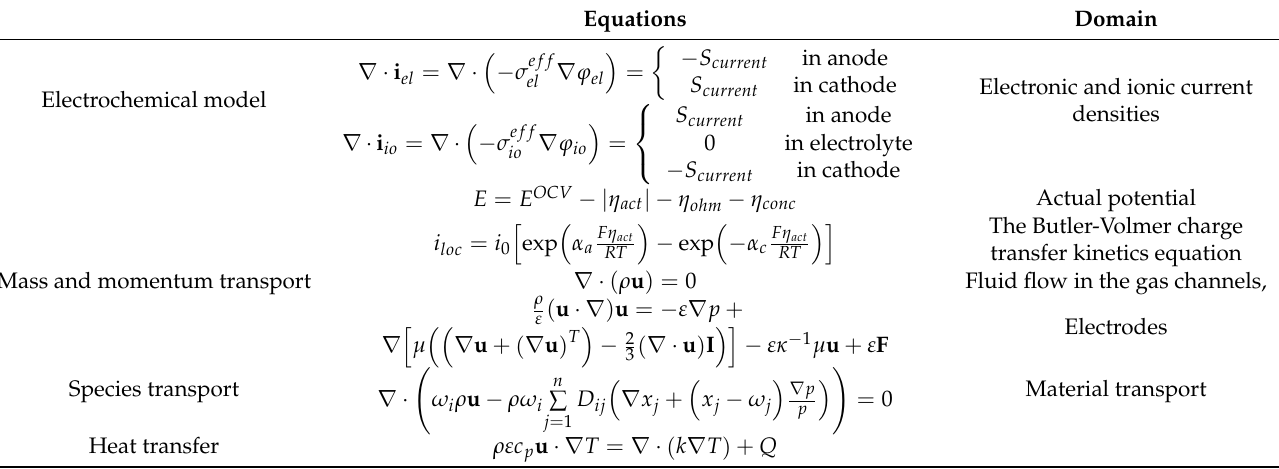
Table 2. Governing